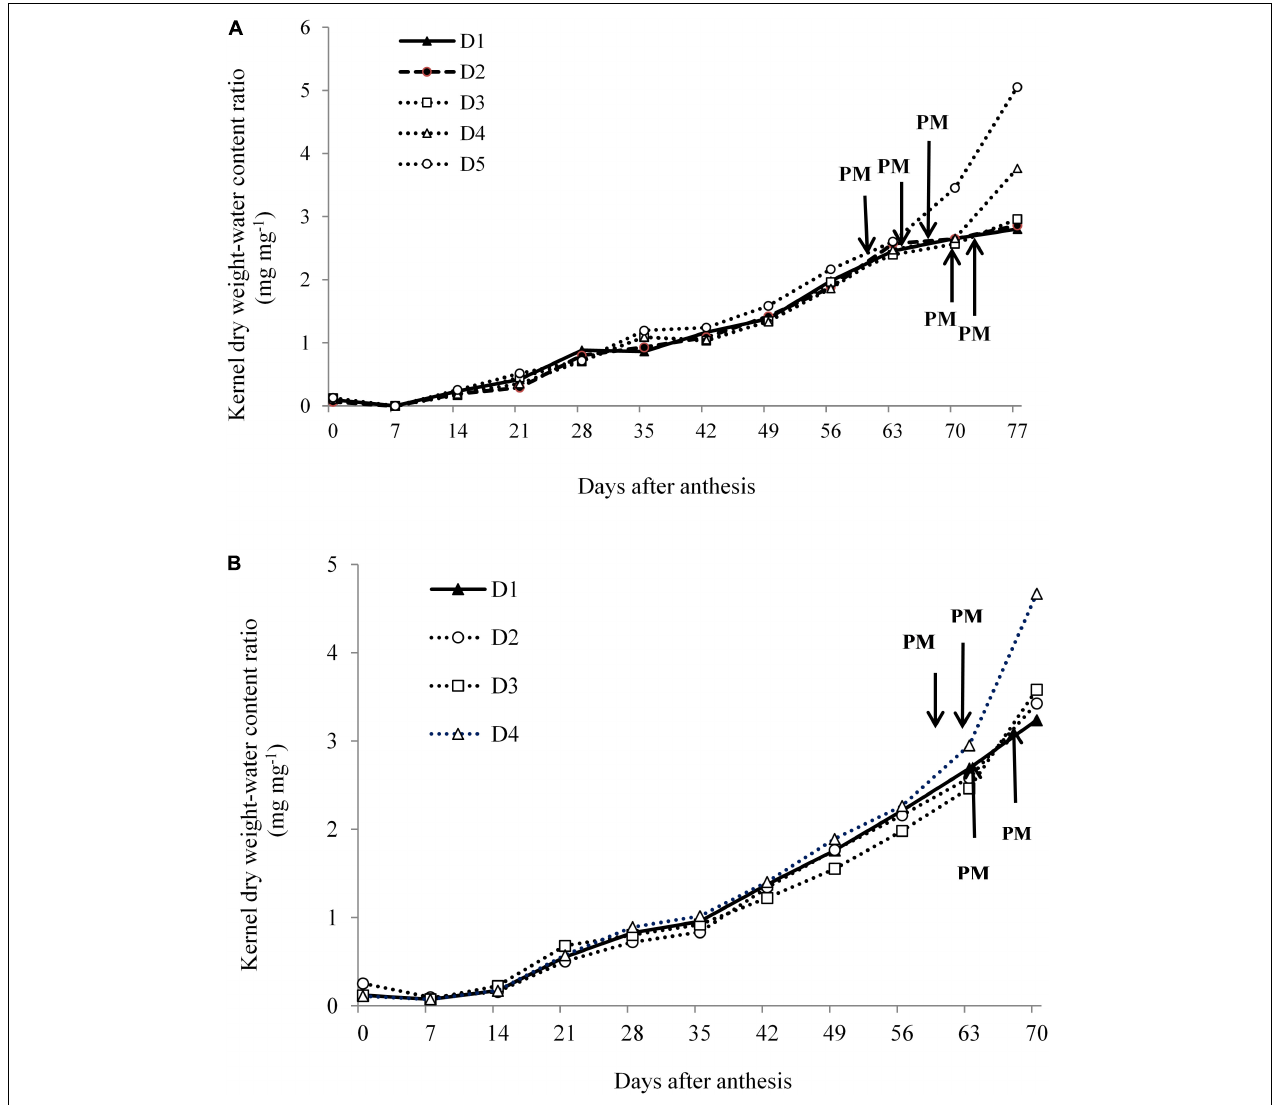
FIGURE 9 | Kernel dry weight-water content ratio under different water regimes at 7 days intervals from days after anthesis to physiological maturity in Expt. 1 (A) and Expt. 2 (B)